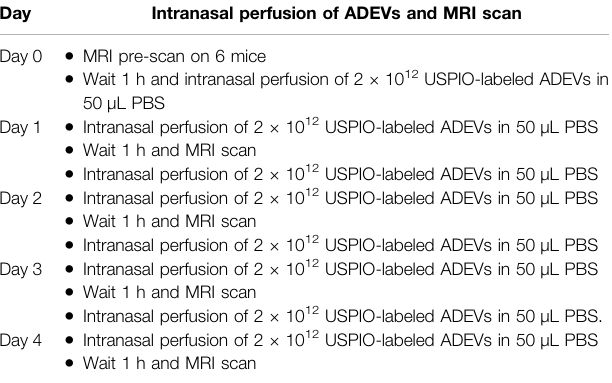
TABLE 1 | Intranasal perfusion of USPIO-loaded mouse astrocyte-derived EVs. Day Intranasal perfusion of ADEVs and MRI scan Day 0 (cid:129) MRI pre-scan on 6 mice (cid:129) Wait 1 h and intranasal perfusion of 2 × 10 12 USPIO-labeled ADEVs